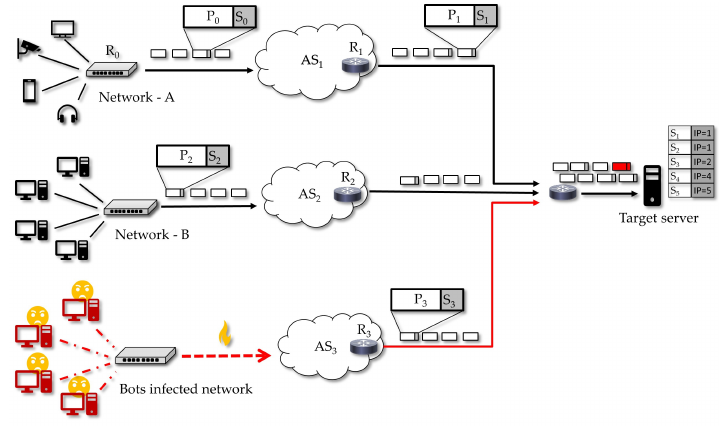
Figure 7. A possible utilization scenario for the proposed DoS defense. During a DoS attack, the target server requires signed traffic from the senders and, since in this case just Network-A and Network-B can do it, the other sender is